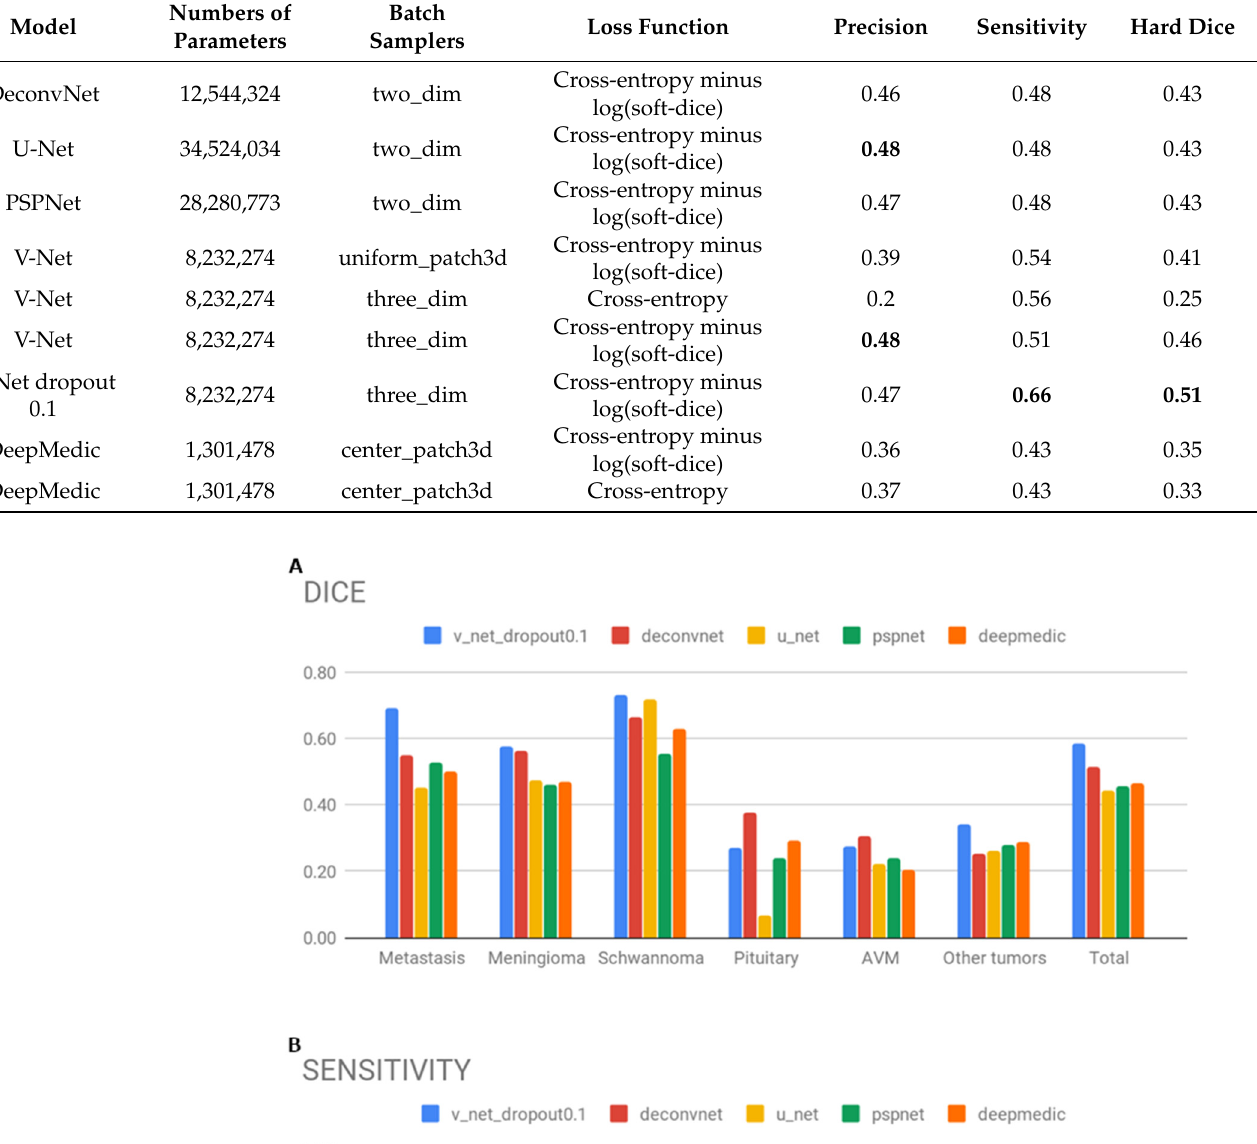
Table 5. Performance of different models on the NTUH dataset.